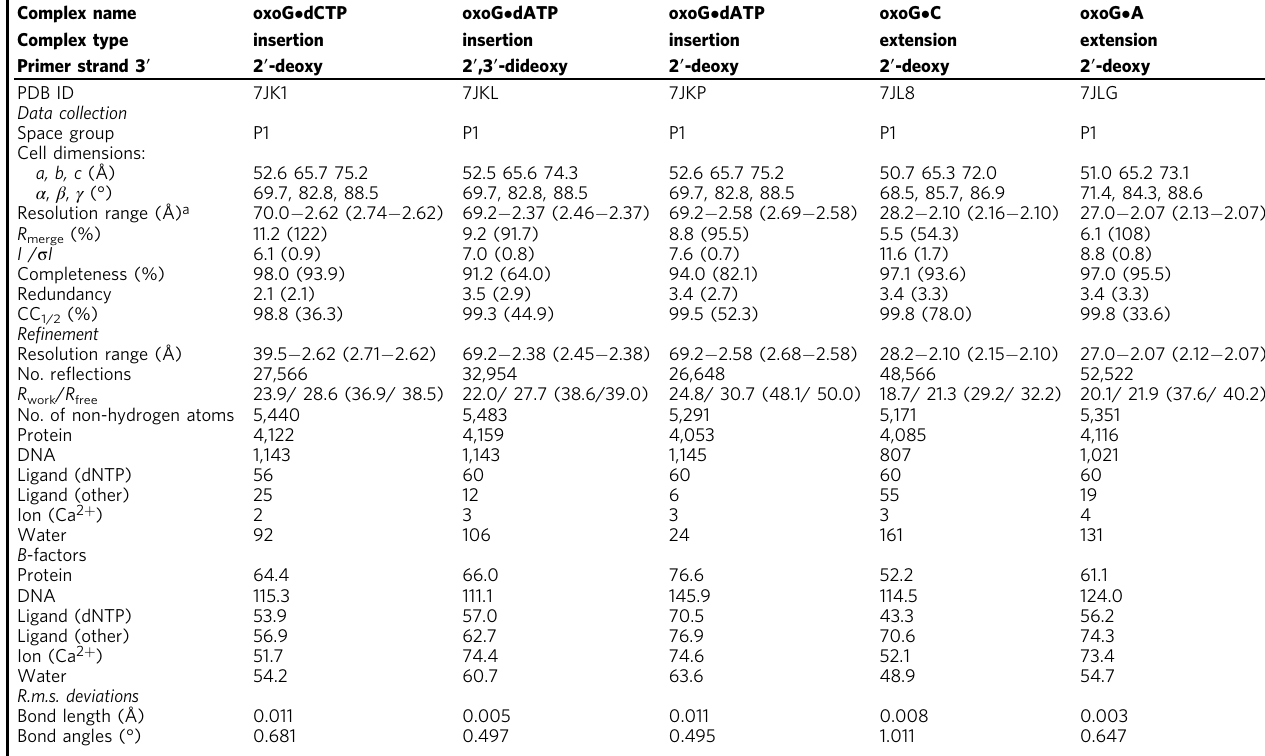
a Values in parentheses are for highest-resolution